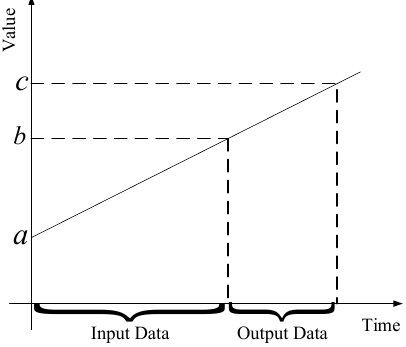
Figure 7. Normalization and inverse normalization of linear prediction using neural networks.